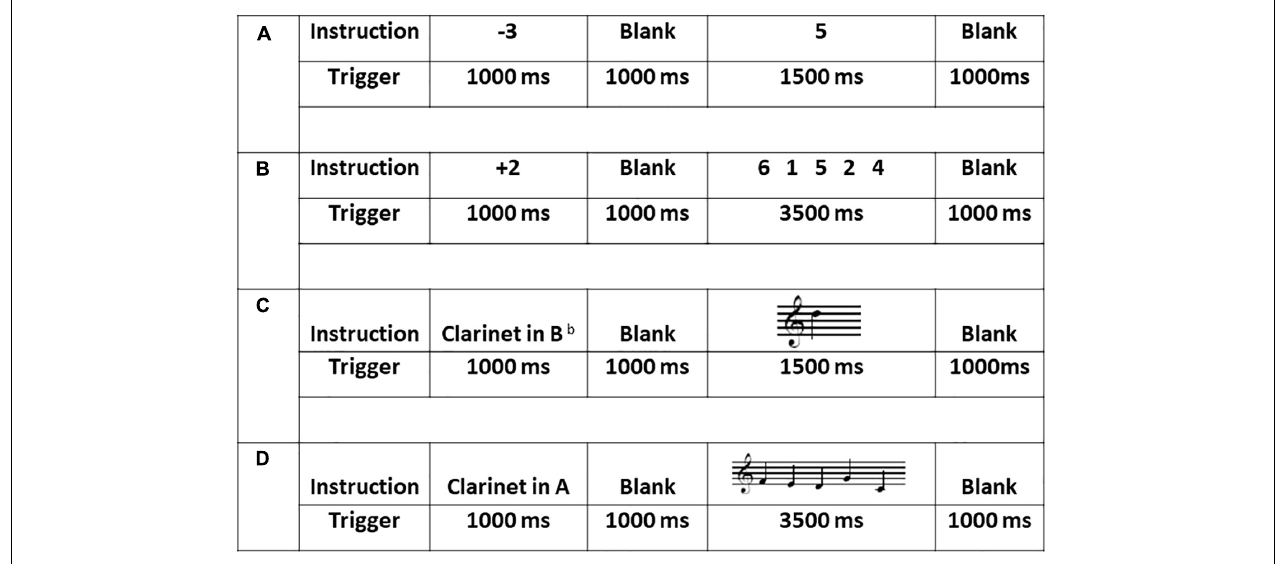
FIGURE 1 | Sample stimuli, duration and procedure across the four experimental tasks: (A) the one single-digit calculation task (1D); (B) the five single-digit calculation task (5D); (C) the one-note transposing task (1T); and (D) the five-note transposing task (5T). All stimuli for 1T and 5T were presented on treble clef and all cues (transposing instruments) were presented using word